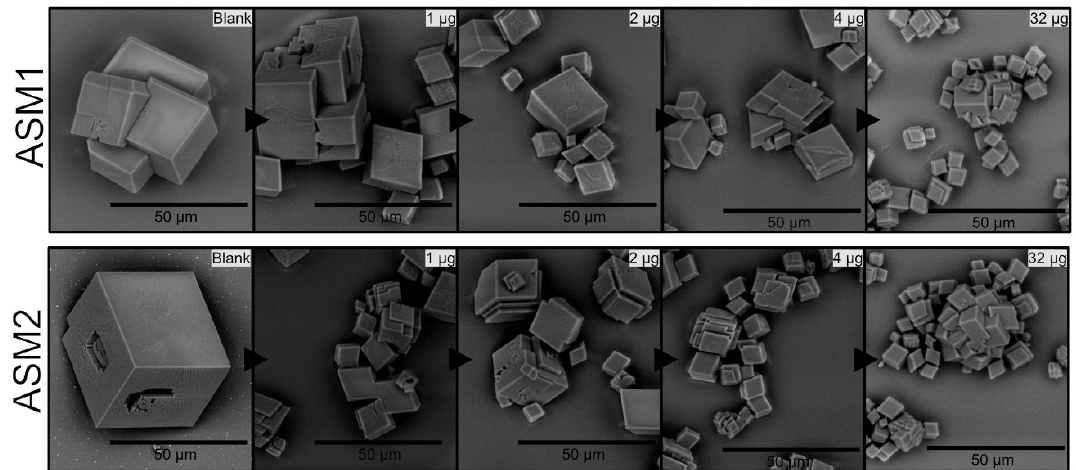
Figure 8. In vitro crystallization of calcite in the presence of ASM1 (top panel) and of ASM2 (lower panel) extracted from Argonauta hians shell. Note that both extracts exert moderate effects, even at high concentrations.